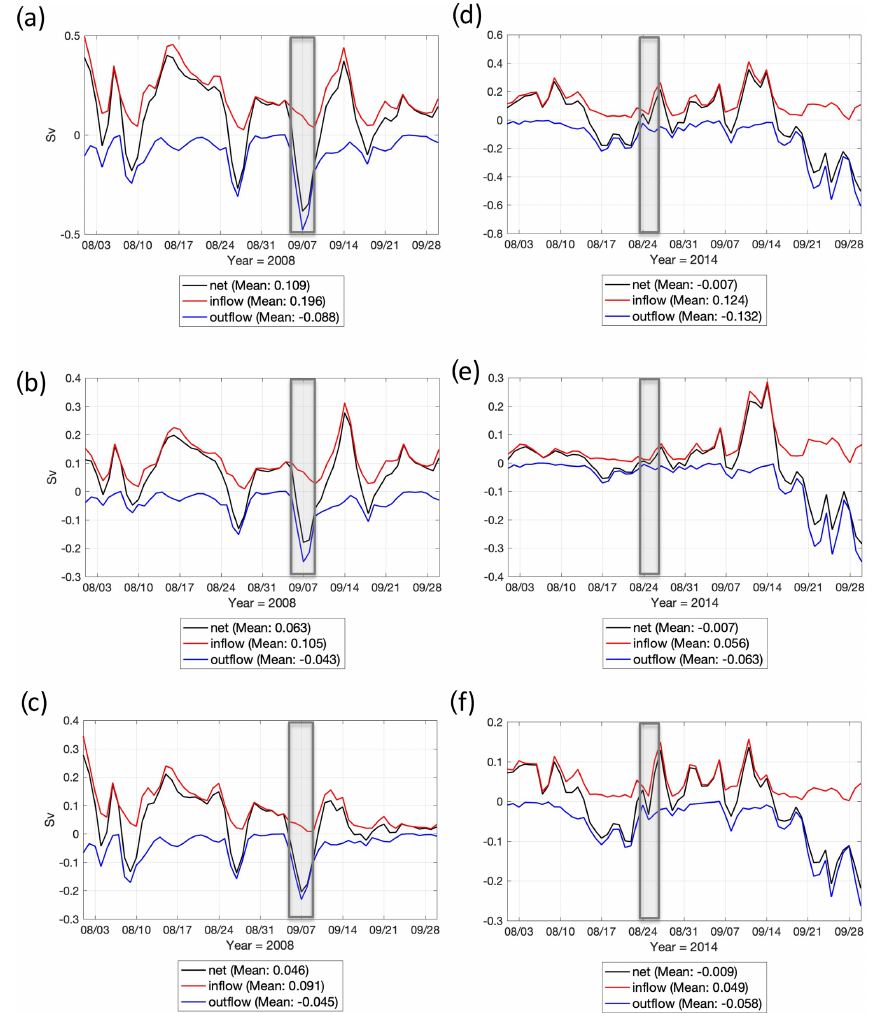
Figure 9. Daily modelled volume flux from the 9km simulation across section 3 during August–September 2008 for all water masses (a) , BSW only (b) , and WW only (c) , and during August–September 2014 for all water masses (d) , BSW only (e) , and WW only (f) . The grey box shows the time period during which observations were collected. Inflow values are northward and outflow is southward. The mean values shown are for the 2-month time period